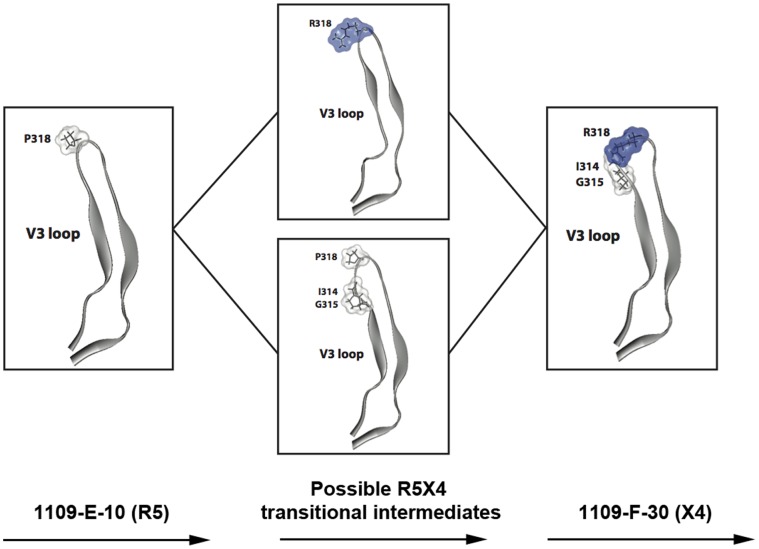
A model for the transition from R5 to X4 C-HIV phenotype in subject 1109.Close up views of the V3 loop structure of the R5 1109-E-10 gp120 (left), possible R5X4 intermediates (center, top and bottom) and the X4 1109-F-30 gp120 (right). Amino acid residues that contribute to the acquisition of CXCR4-usage in patient 1109, as determined by the Env mutagenesis studies, are represented as stick models and their molecular surface is colored according to polarity (white, non-polar; blue, positively charged). In this model, Envs that acquire either Arg318 (center, top) or the Ile314-Gly315 insertion (center, bottom) in the context of additional gp120 “scaffold” mutations are possible “transitional” R5X4 intermediates, with X4-phenotype conferred by the acquisition of both changes (right).